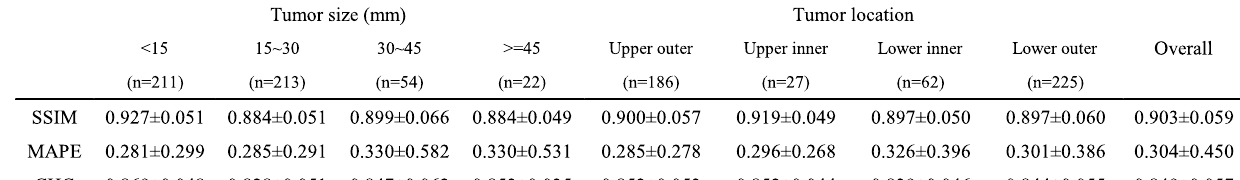
con fi denceintervalsofAUC. d Comparisonofdiagnosticperformancestrati fi edby tumor location. n indicates the number of cases in the interval. Error bar indicates 95% con fi dence intervals of AUC. e Results of several examples. Source data are provided as a Source Data fi